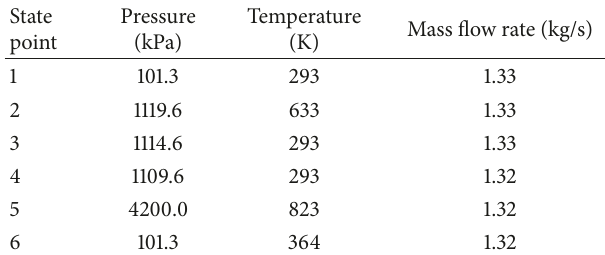
Table 2: Thermodynamic properties and mass flow rates of air at different state points for diabatic OCAES system (see Figure 1 for state